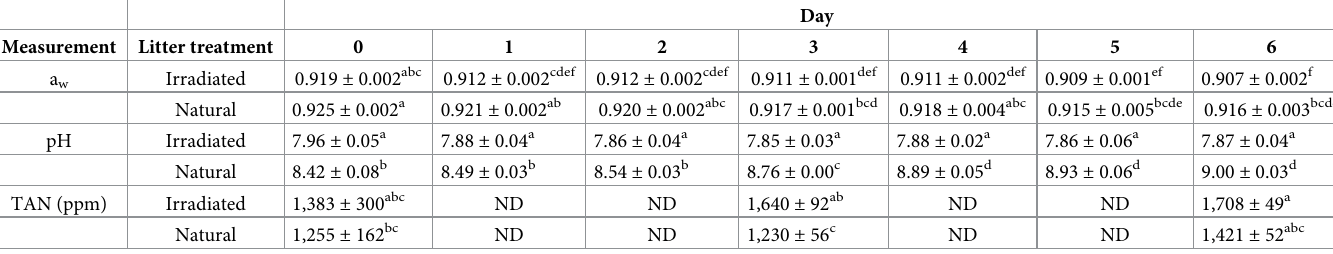
Reported values are mean ± standard deviation (n = 3). For each measurement, means with the same letter across rows and columns are not significantly different ( P > 0.05). ND, not